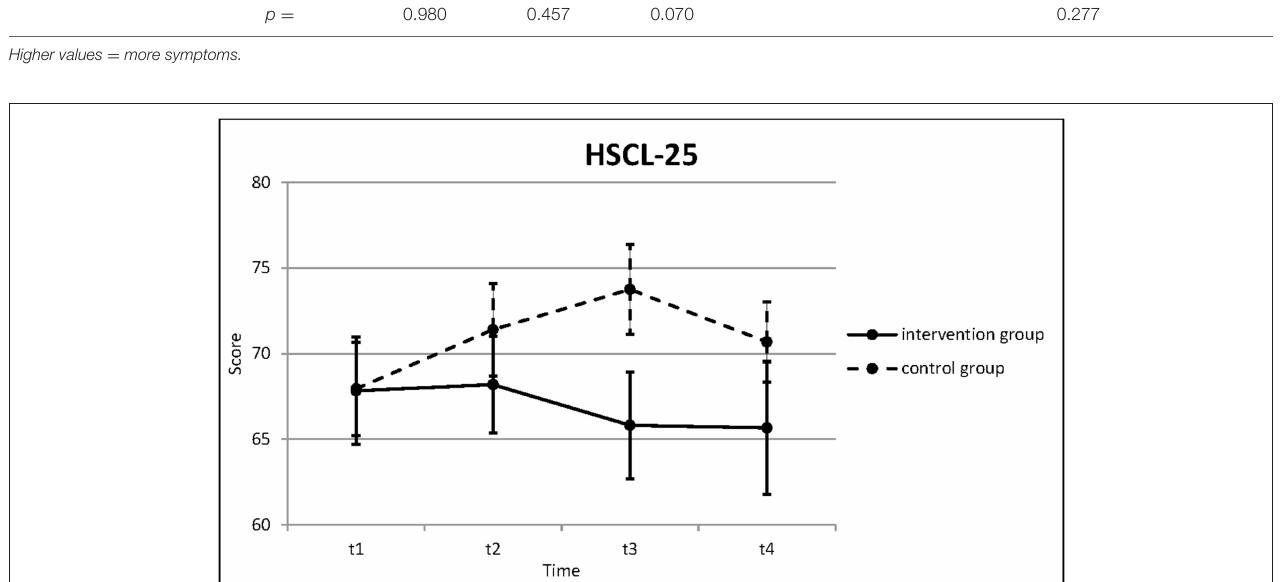
FIGURE 1 | Hopkins Symptom Checklist